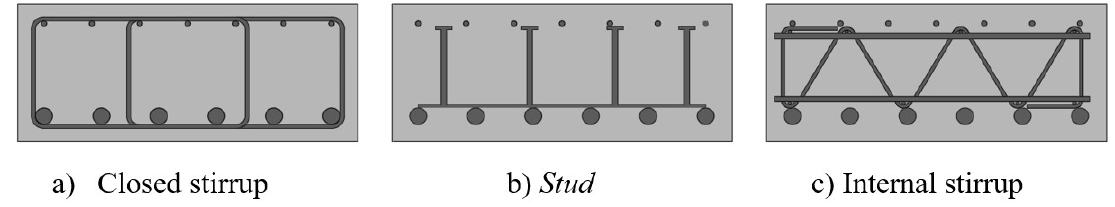
Figure 2 – Cross section detail with different types of transverse